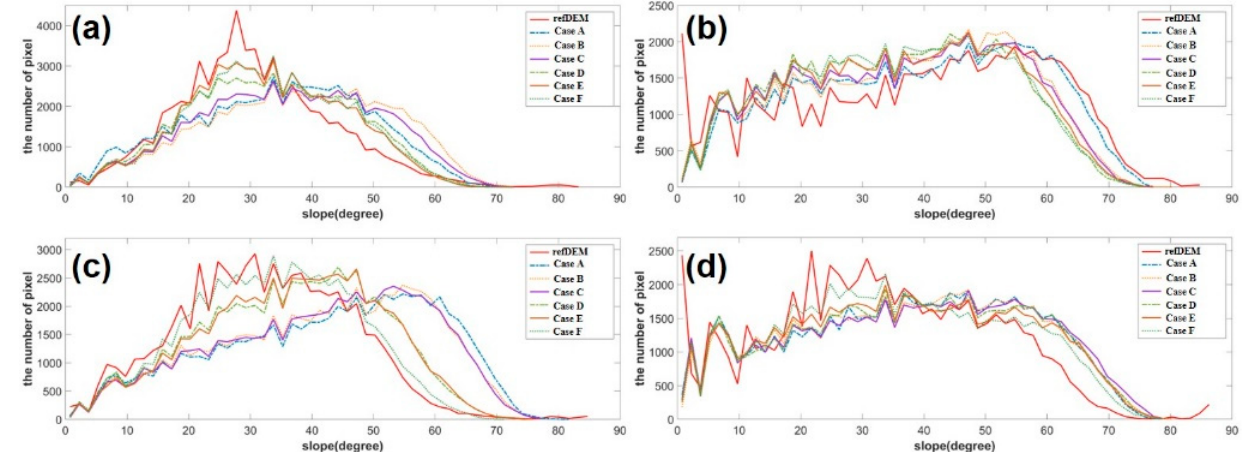
Figure 7. Results based on the different combinations of topographic features. Ref DEM represents